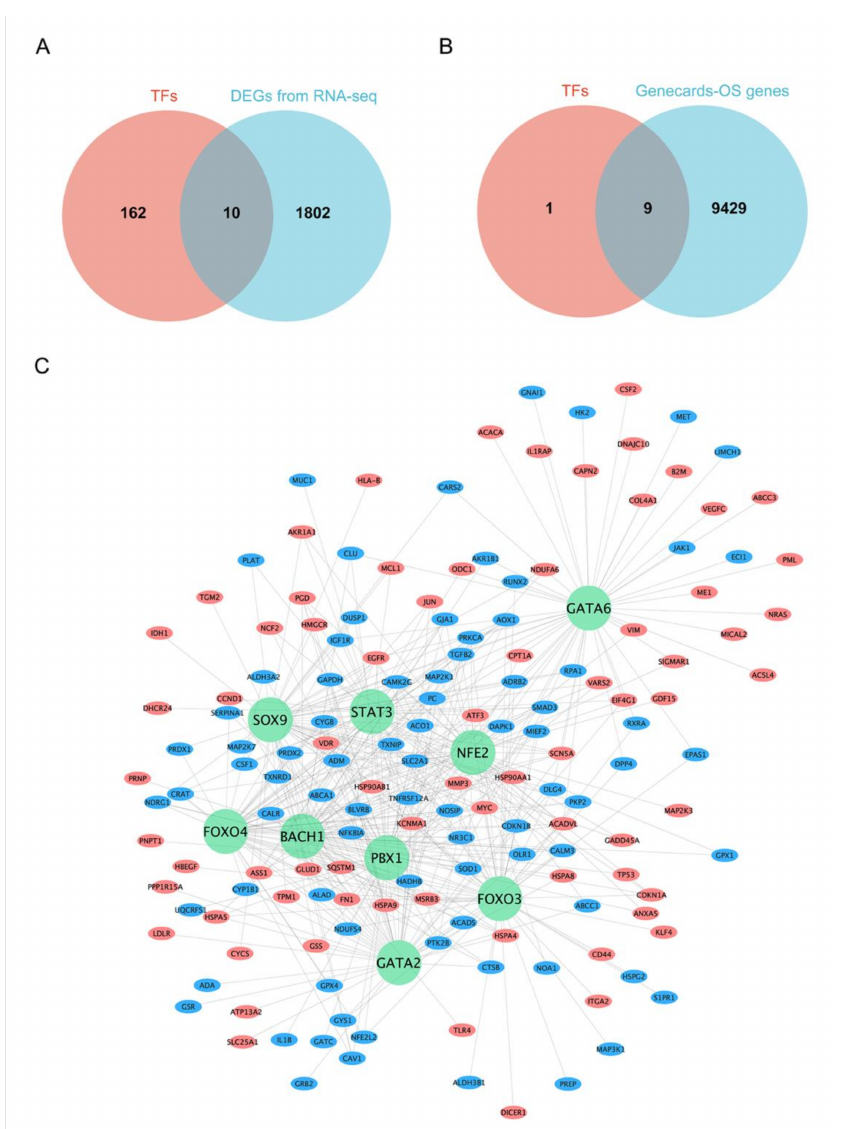
Figure 4. Prediction of TFs for DEGs and construction of oxidative stress-associated TF-mRNA regulatory network. ( A ) Ten TFs with altered expression after PS-NP exposure in BEAS-2B cells. ( B ) Nine TFs that related to oxidative stress. “OS” represents oxidative stress. ( C ) Oxidative stress- associated TF-mRNA regulatory network of BEAS-2B cells in response to PS-NP exposure. The green circles represent TFs related to oxidative stress. The red ellipses represent up-regulated DEGs related to oxidative stress while blue ellipses represent down-regulated DEGs related to oxidative